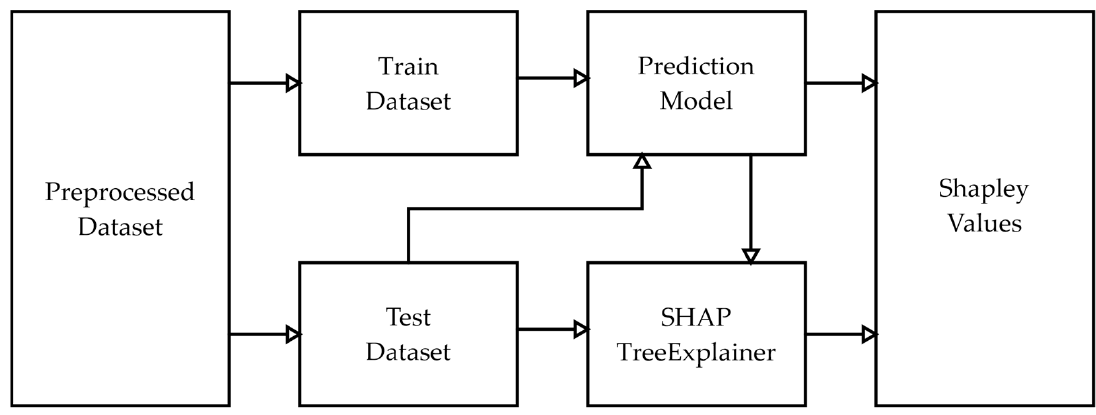
Figure 5. Experimental framework.